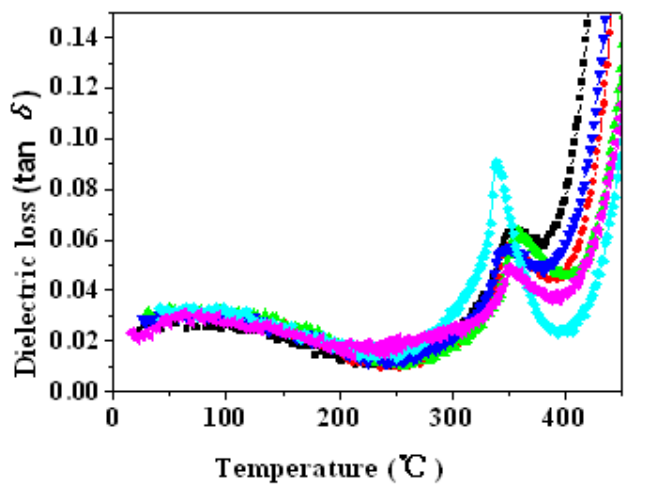
Figure 12. Variations in dielectric loss (1 kHz) with temperature in PZTN ceramics sintered at 1260 °C for 2 h.